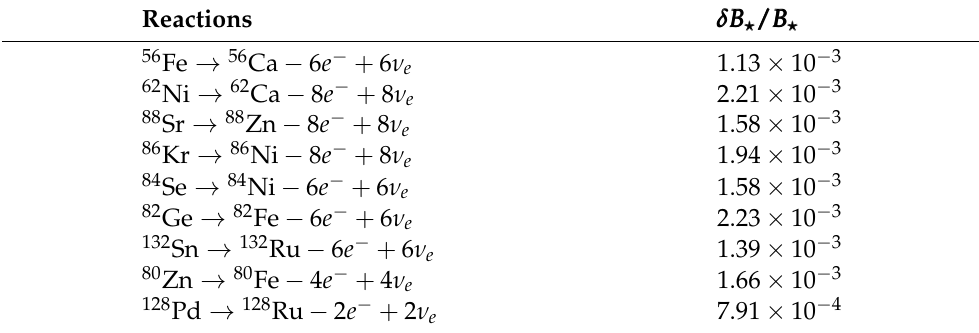
Table 7. Relative decay of the magnetic field required to entirely replace the given element through the indicated chain of electron captures by the nuclei listed in Table 1 in the outer crust of a magnetar for B (cid:63) = 2000, from the initial pressure given in [21] to the pressure at which the last capture occurs.